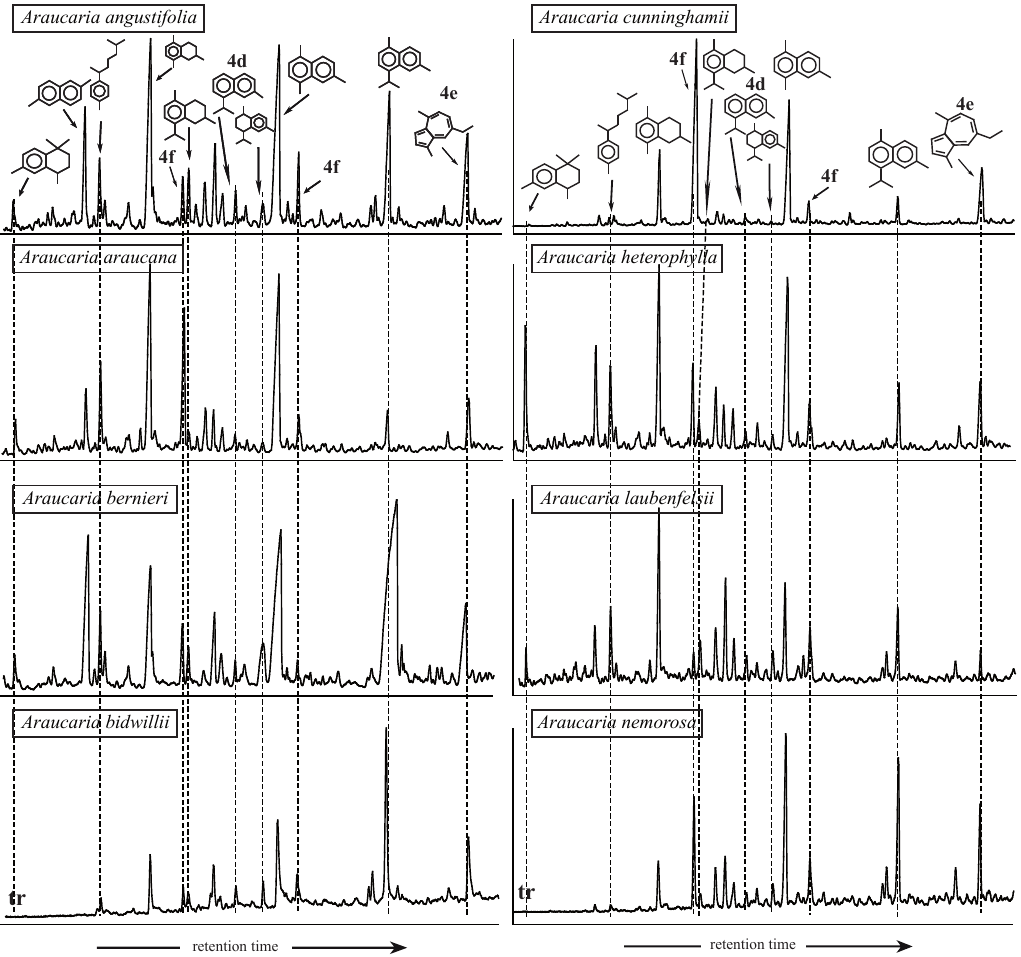
Fig. 3. Partial chromatograms (sesquiterpenoids retention time window) of aromatic fraction of pyrolysates of Araucaria species. The mass spectra of 4d, 4e and 4f are given in Fig. 4. tr: at trace